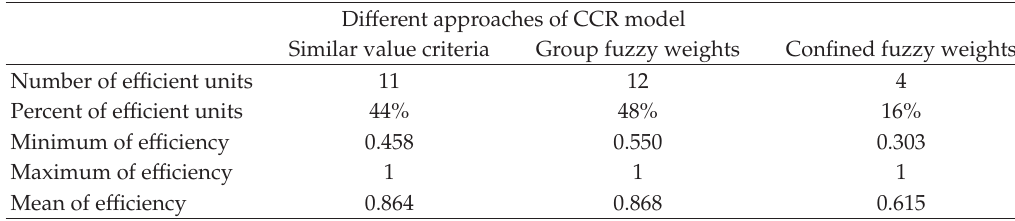
Table 9: Comparative display of e ffi ciency for bank